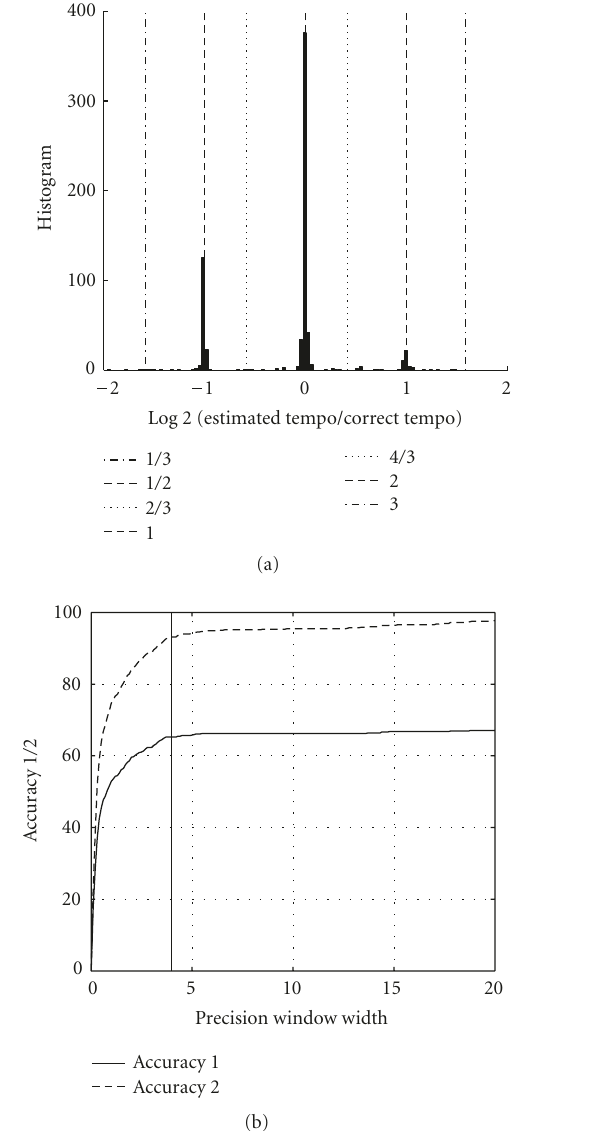
Figure 10: (a) Histogram of the ratios in log-scale between es- timated tempi and correct tempi; (b) accuracy versus precision window width (in (%) of correct tempo) for the ballroom-dancer database.